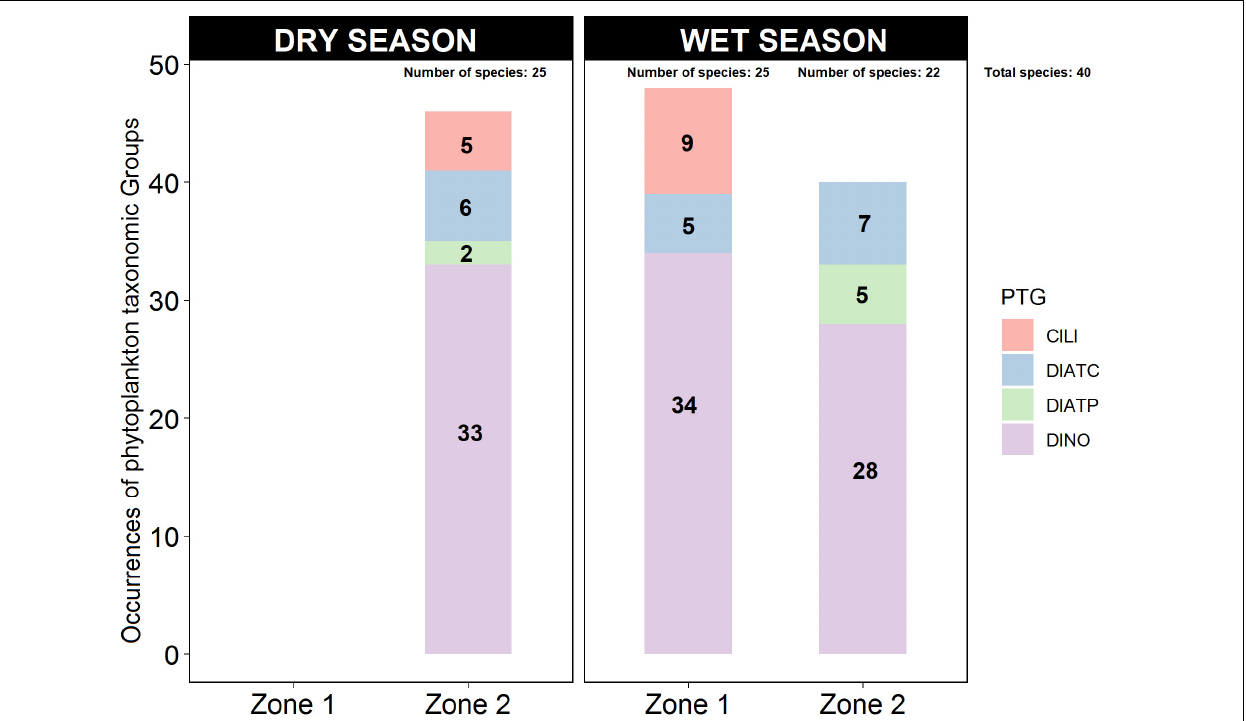
FIGURE 4 | Occurrences of phytoplankton taxonomic groups (PTGs) in Zones 1 and 2 of the study area during the dry and wet seasons. For the period 1997–2017, a total of 46 PTG occurrences with 25 species were reported in the dry season in Zone 2, 48 PTG occurrences with 25 species were reported in Zone 1, and 40 PTG occurrences and 22 species were reported in Zone 2 in the wet